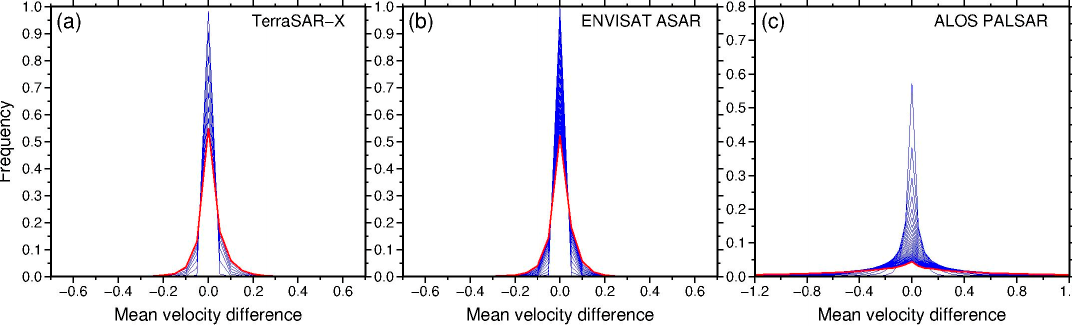
Figure 4. Histograms of mean deformation rate difference between h_ratio > 1 and h_ratio = 1 for: X band ( a ); C band ( b ); and L band ( c ). The blue solid lines represent the deformation rate difference of each case. The red solid lines represent the significant test of deformation rate difference is firstly passed for each platform. For brevity, the histograms of remaining h_ratio , which also passed the significant test, are not plotted.